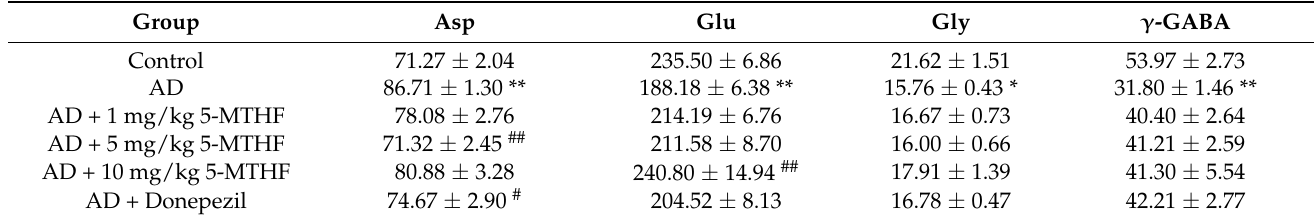
Table 2. Amino acid content of rat brain tissue (μg/mL, n = 10).